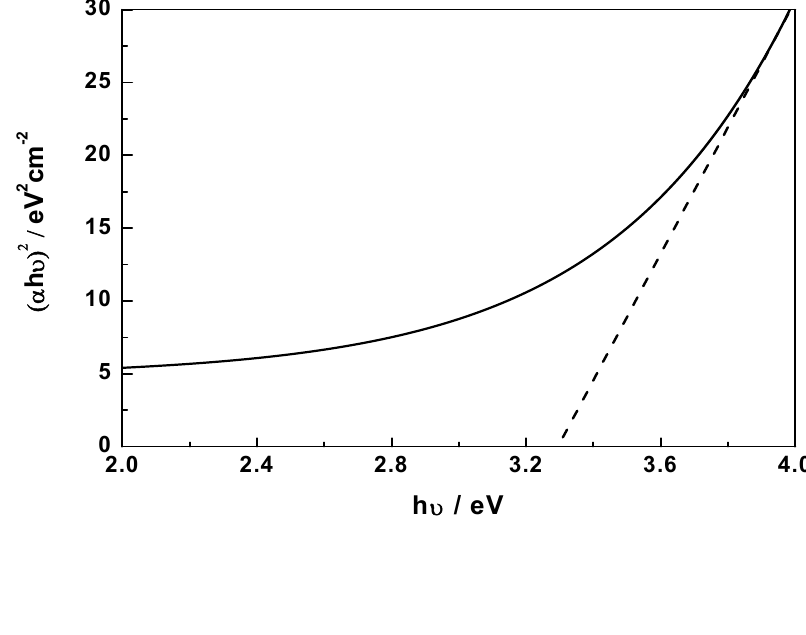
Figure 7. Evaluation of the band gap of flower-like NiO by the extrapolation of ( α h ν ) 2 versus h ν